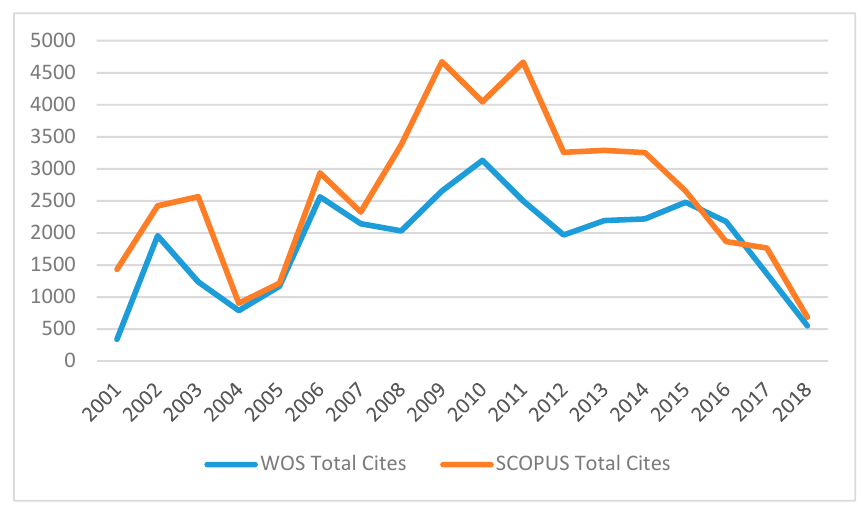
Figure 3. Average number of articles on WOS vs Scopus.